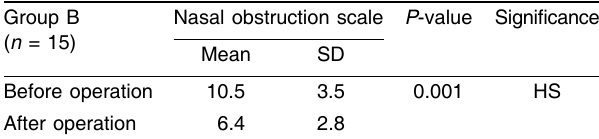
Table 6 NOSE score preoperative and postoperative